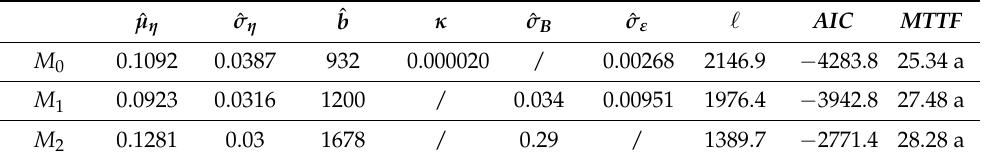
Table 3. The parameters of three degradation models with TWT CSADT degradation data.